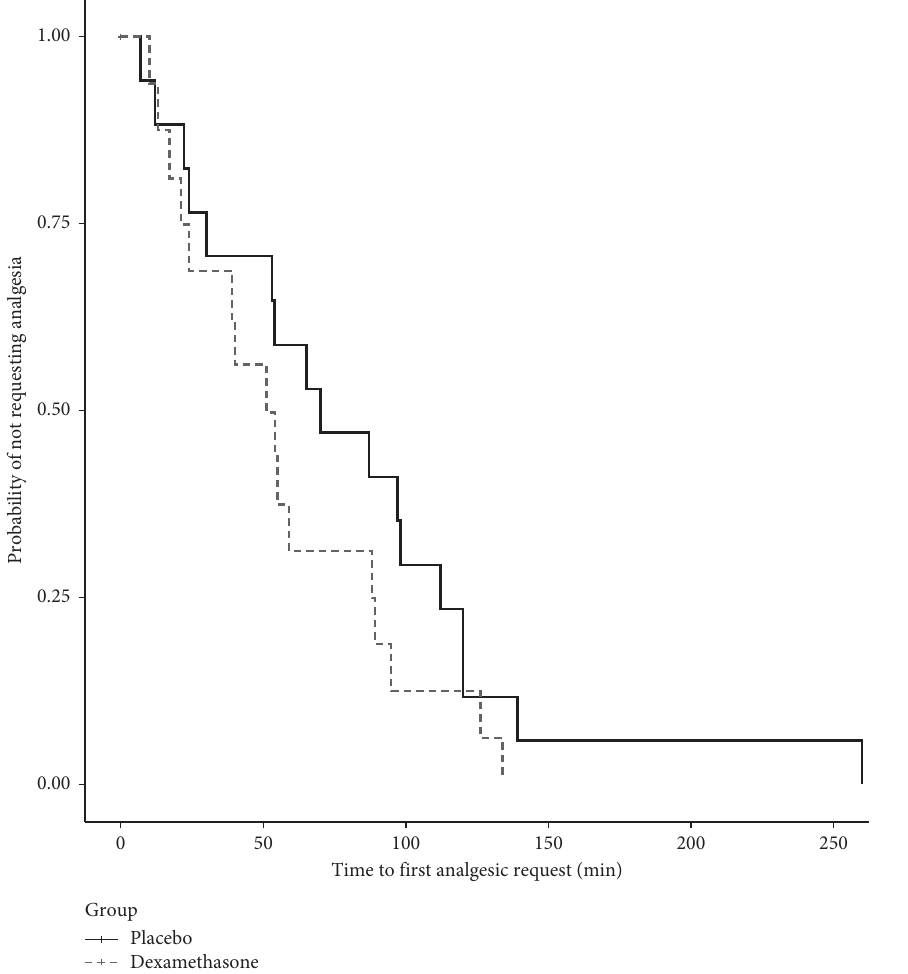
Figure 2: Kaplan–Meier curve for time to first analgesic request. There was no significant difference in the time to first analgesic request between cesarean delivery patients that received 8mg dose intravenous dexamethasone intraoperatively and those that received placebo ( P � 0 .